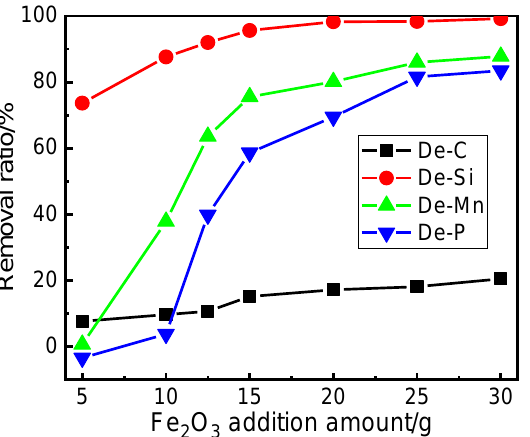
Figure 4. Effect of the Fe 2 O 3 addition amount on the removal ratios of the element contents in the hot metal after dephosphorization.